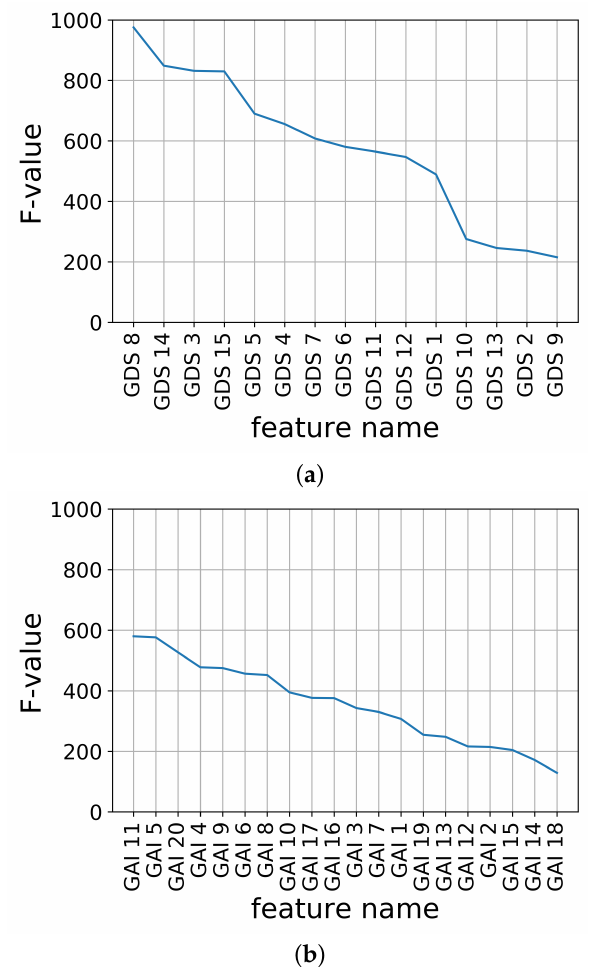
Figure 2. Feature importance of assessment data using F-value . ( a ) K-SGDS, ( b )